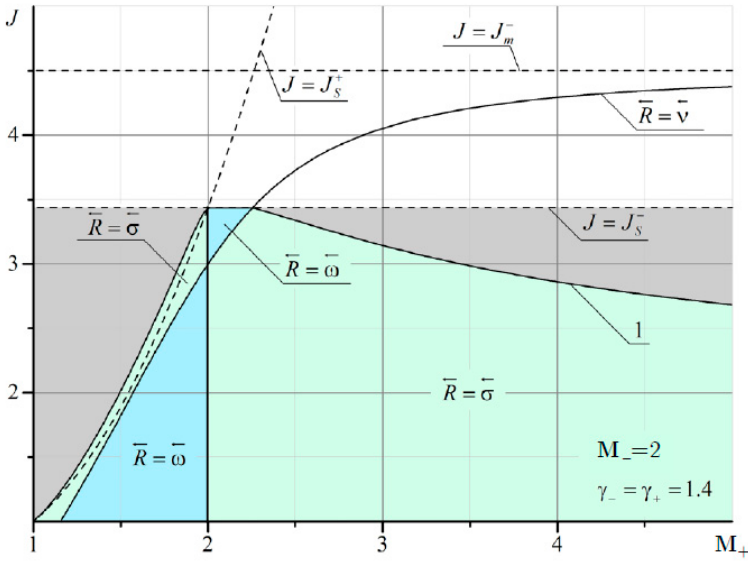
Figure 11. Domains of existence of various types of hydrocarbons formed during refraction of a shock with intensity J propagating from a flow with a Mach number M − = 2 into a flow with a Mach number M + . The grey area corresponds to irregular refraction with a supersonic flow M 1 > 1 behind a shock σ 1 , and white area corresponds to irregular refraction with a subsonic flow behind a shock σ 1 . It can be seen that at M – = 2 and M + < 2, there are quite extensive regions with both the reflected shock wave σ 3 and the reflected rarefaction wave ω 3 . As M – increases, the domains of existence of the reflected σ 3 at M + < M – are significantly reduced (Figures 12 and